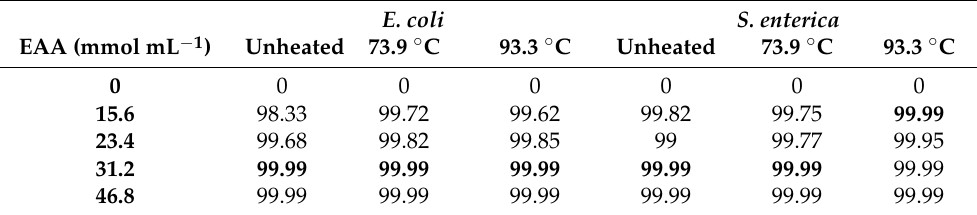
Table 3. MBC determination for EAA.